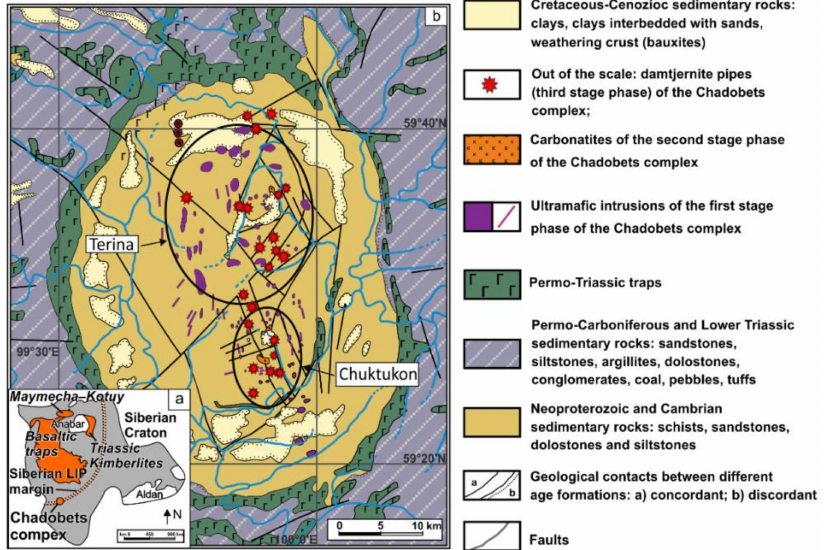
Figure 1. ( a ) Location of the Chadobets ultramafic lamprophyre (UML)–carbonatite complex within the Siberian Large Igneous Provence (LIP) on the Siberian Craton. ( b ) Geological scheme of the Chadobets alkaline complex